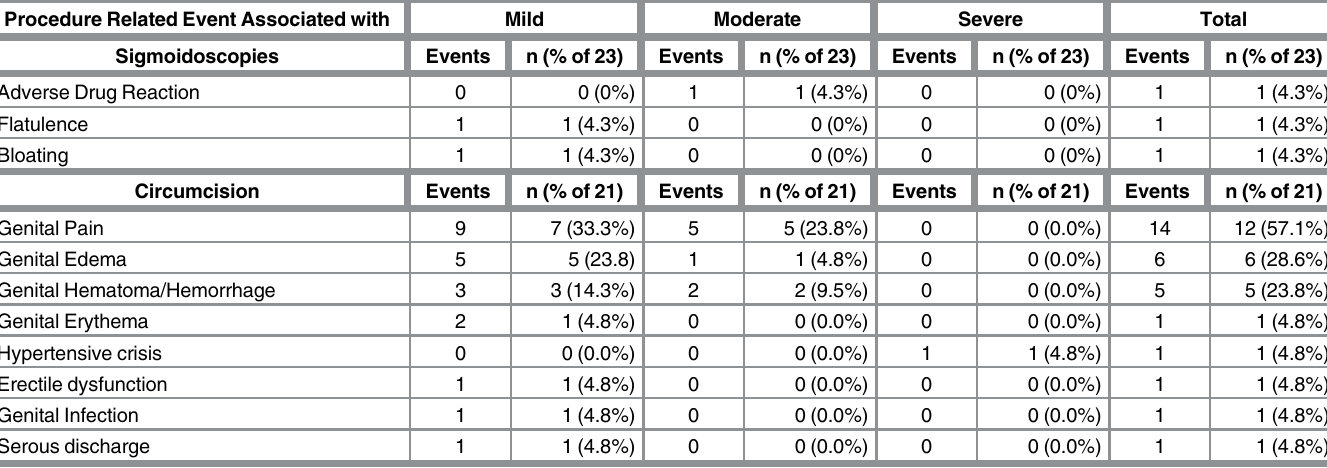
Table 2. MedDRA-coded Procedure Related Events. * Procedure Related Event Associated